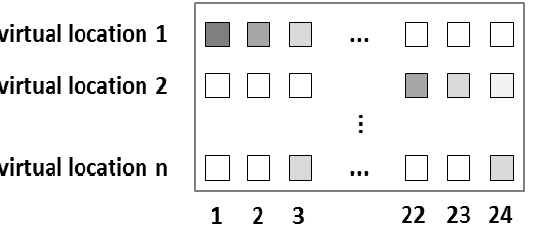
Figure 4. Concept of the probability matrix; darker colors represent higher probability.